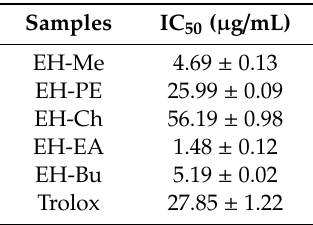
Table 5. Lipid peroxidation inhibitory activity of